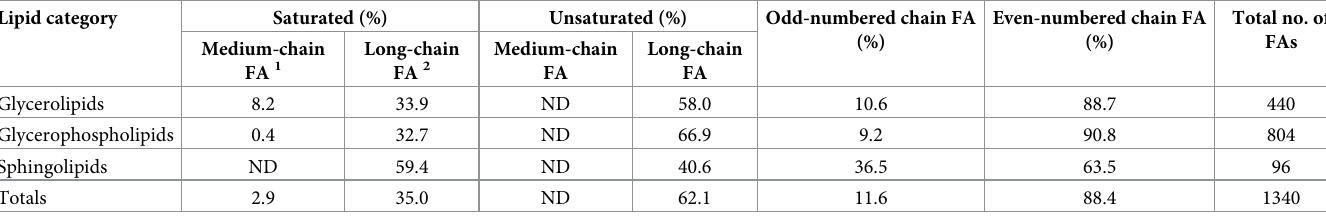
Table 2. Fatty acyl (FA) composition of identified lipid species in the lipidome of Ascaris suum . Lipid category